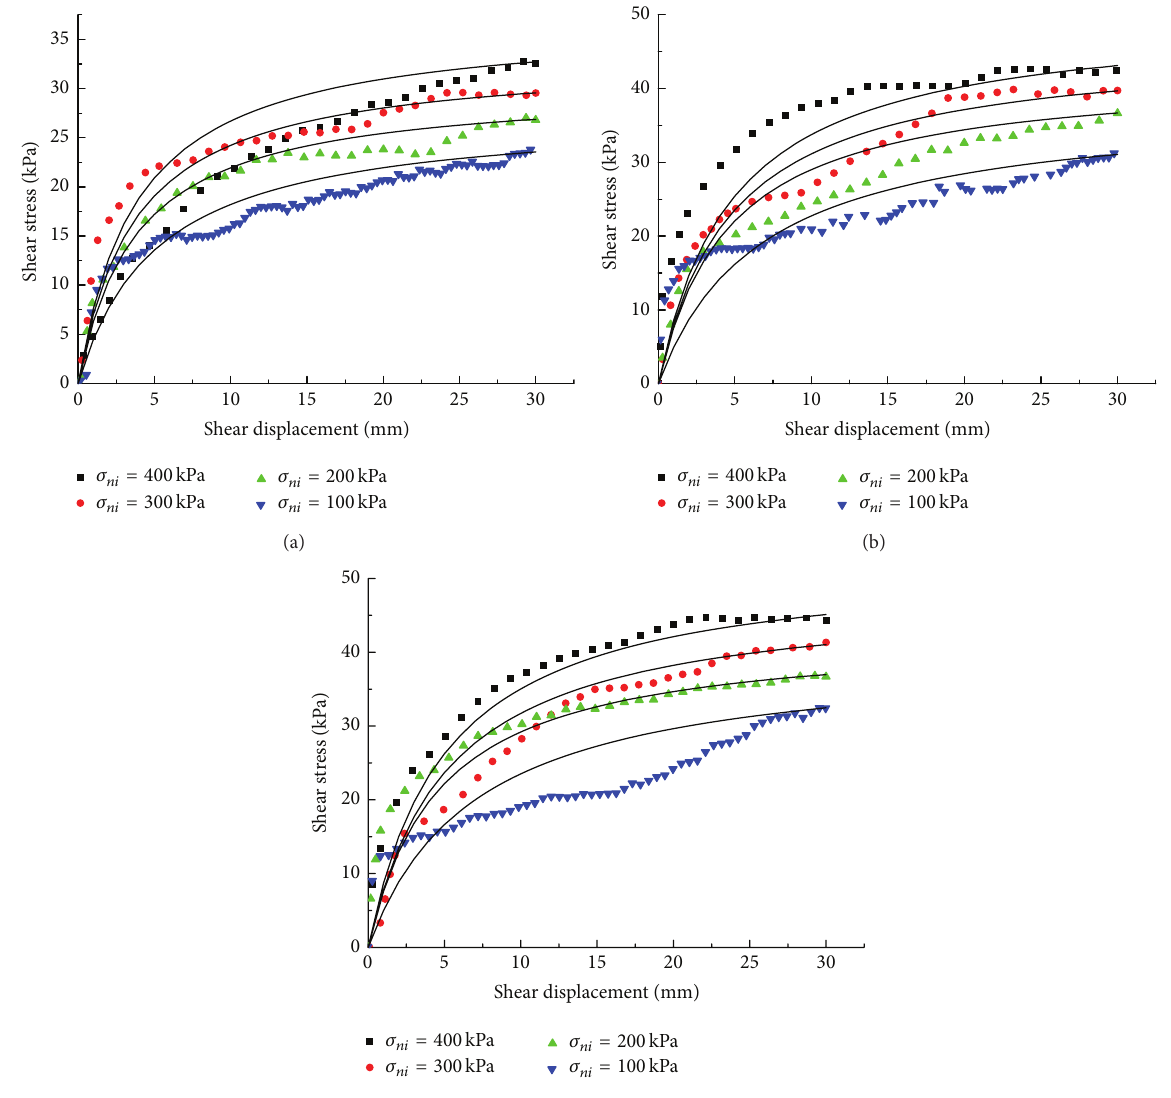
Figure 15: Shear-stress-displacement curves of the interface between clay and concrete ( 𝜎 𝑛 = 100